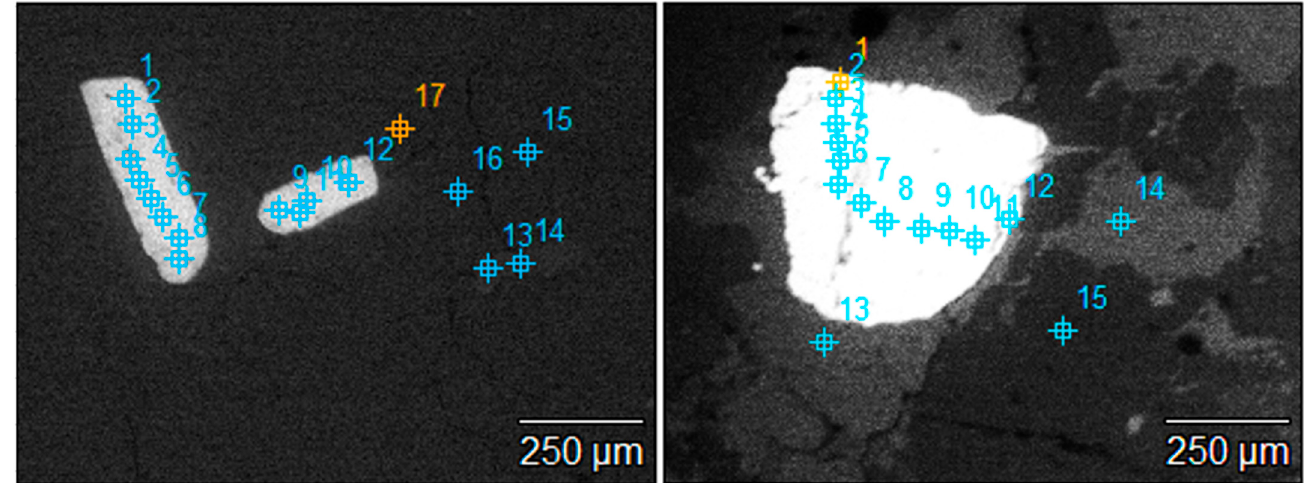
Figure 4. Backscattering electron microphotography of the columbite–tantalite grains with the marked analysis points.